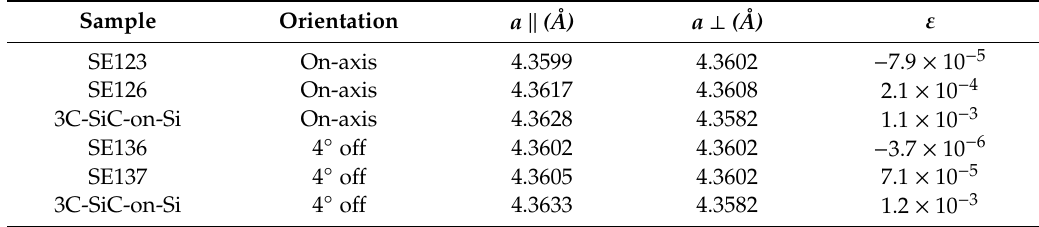
Table 1. Lattice parameters calculated from XRD 2θ-ω scans on SE-grown material and 3C-SiC-on-Si material.